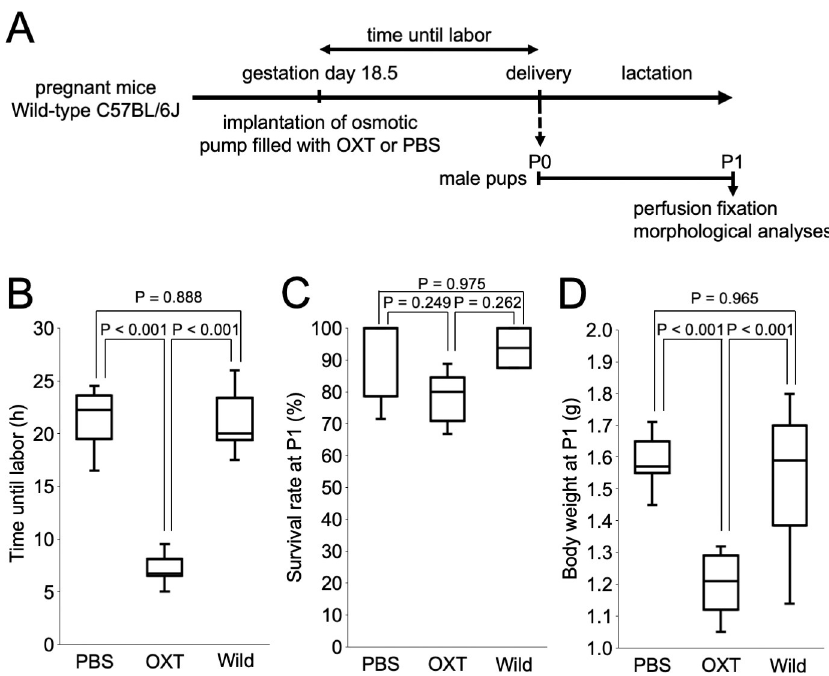
Fig 1. Study design and verification of reproducibility of induced labor model mice. (A) Experimental design of induced labor model and pups. At gestational day 18.5 an osmotic pump was implanted subcutaneously in anesthetized mice. The male pups were analyzed at 24 h (P1) after birth. (B) Time until labor for each group. Time until labor of the oxytocin (OXT) group was significantly shorter than that of the phosphate-buffered saline (PBS) and Wild groups (P < 0.001, Tukey–Kramer method). There were no significant differences between the PBS and Wild groups. (C) Survival rate of OXT, PBS and Wild groups at P1. There were no significant differences between each group. (D) Body weight of OXT, PBS and Wild groups at P1. The body weight of the OXT group was significantly lower than that of the PBS and Wild groups (P < 0.001, Steel–Dwass test). There were no significant differences between the PBS and Wild